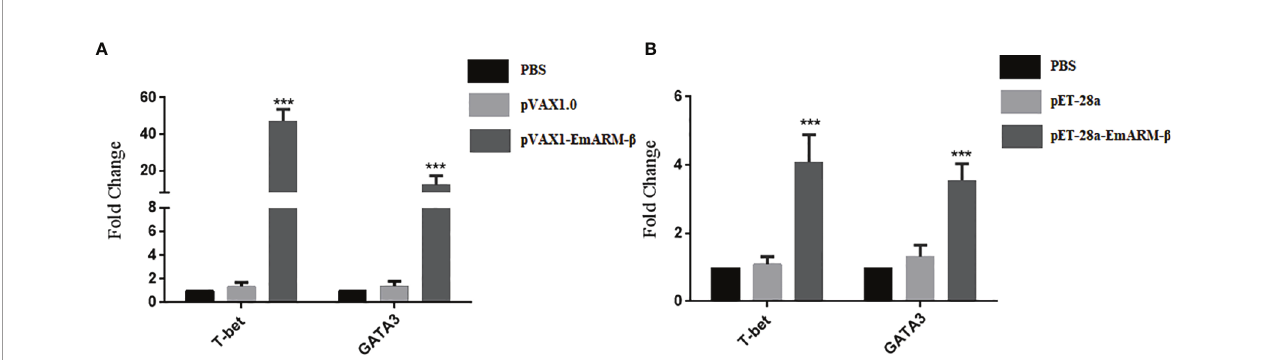
FIGURE 4 | Level changes of T-bet and GATA3 in chickens induced by EmARM- b . Speci fi c transcription factor levels measured by quantitative PCR. (A) Level measurement of speci fi c transcription gene induced by recombinant plasmid pVAX-1-EmARM- b . (B) Level measurement of speci fi c transcription gene induced by recombinant protein pET- 28a-EmARM- b . ***p <